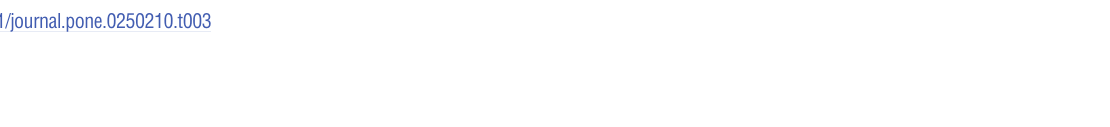
Values are means of four replicates; different letters in the same column indicate significant differences according to DMRT at P � 0 . 05 . Where R = Red light 100%, R7: B3 = Red70%+ Blue30%, B = Blue light 100%, WFL = White Fluorescent